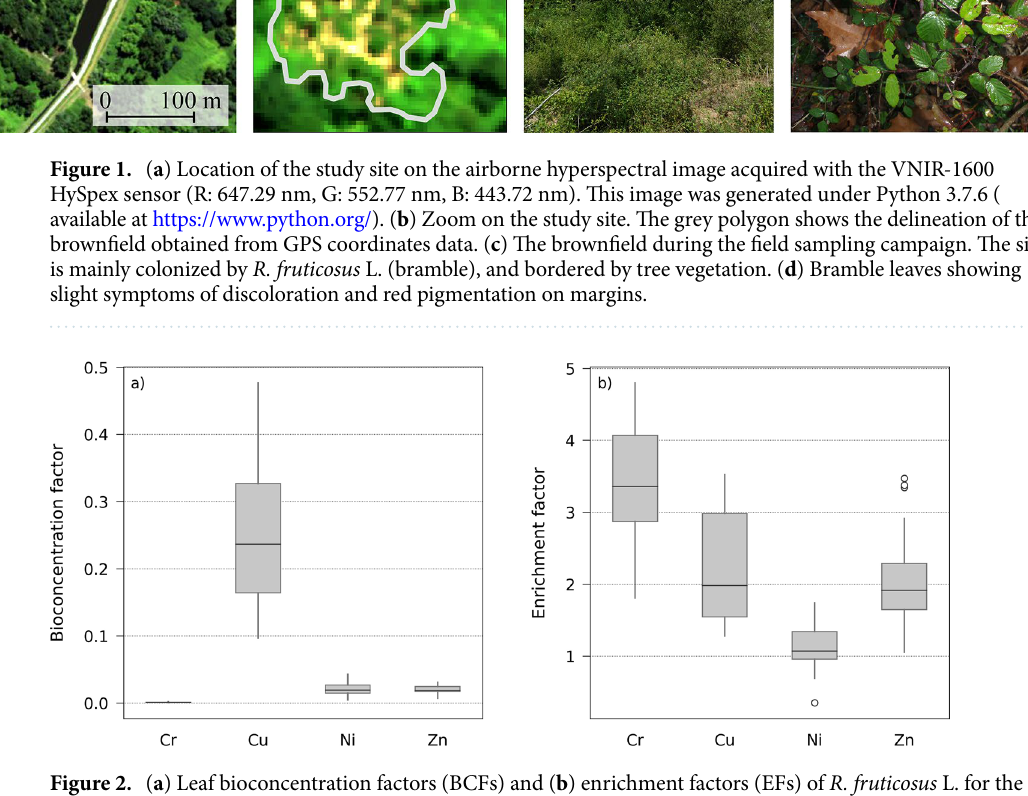
Figure 2. ( a ) Leaf bioconcentration factors (BCFs) and ( b ) enrichment factors (EFs) of R. fruticosus L. for the four heavy metals analyzed on the